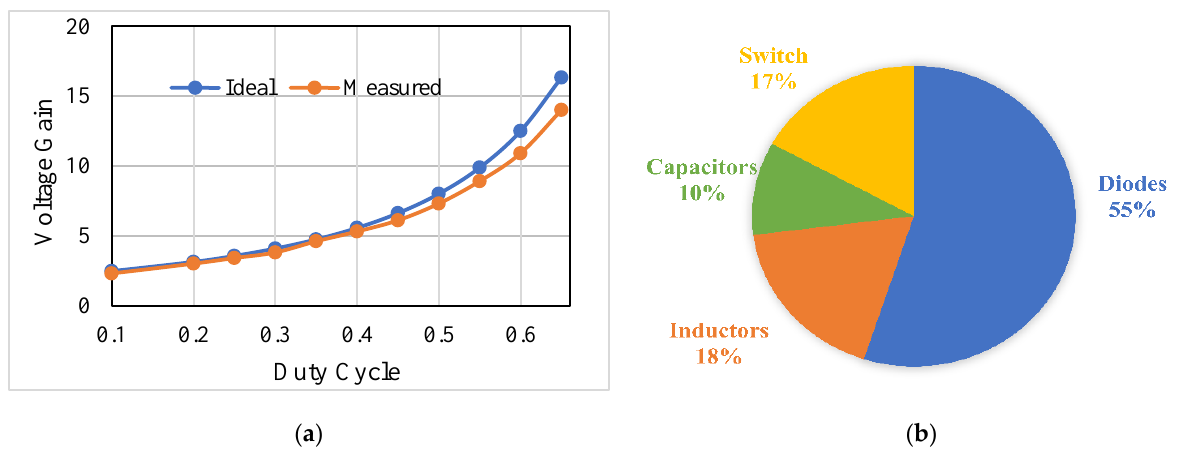
Figure 13. ( a ) Comparison between the ideal and experimental gain of converters I and II. ( b ) Bifurcation of power loss in converters I and II .